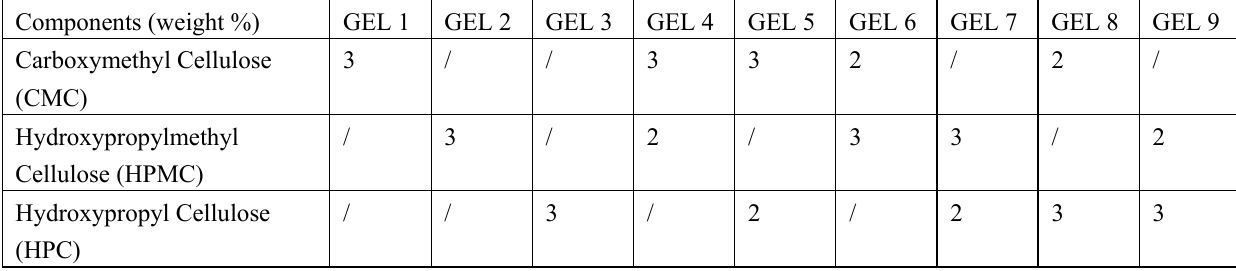
Table 1. Weight % composition of the nine gels; chlorhexidine (CHX) is present at 1% w/w. Components (weight %) GEL 1 GEL 2 GEL 3 Carboxymethyl Cellulose 3 / / 3 / / (CMC) Hydroxypropylmethyl / Cellulose (HPMC) Hydroxypropyl Cellulose